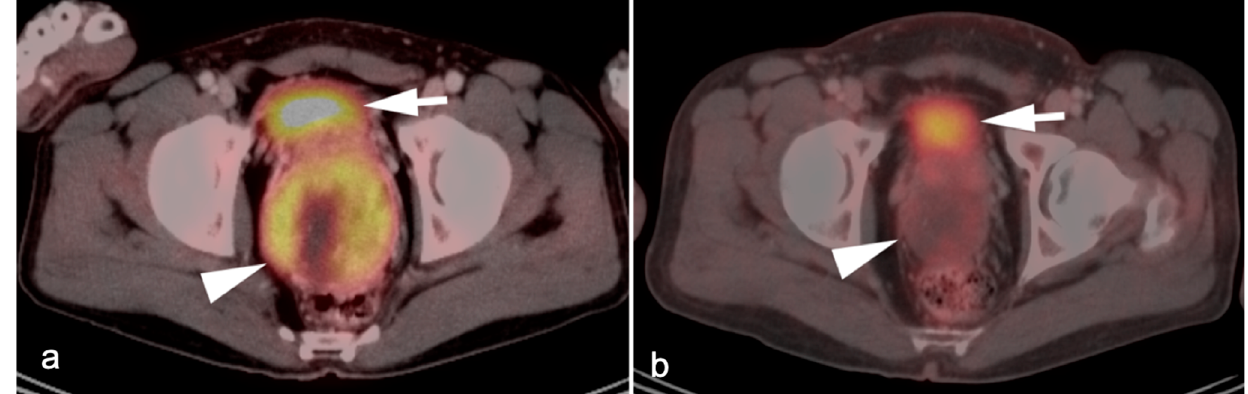
Figure 12. A large rectal carcinoid tumor before ( a ) and after ( b ) treatment with Imatinib. Fused axial PET-CT images of the low pelvis show a significant decrease in metabolic activity with treatment. Urinary bladder is shown by white arrow.